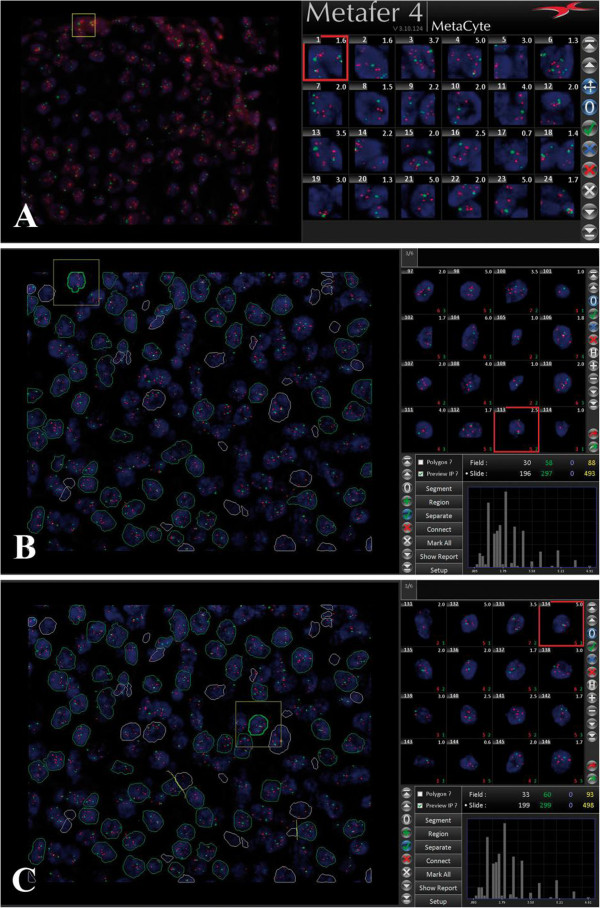
Image analysis of fluorescence signals. A). Automated quantitative image analysis through the tile-sampling classifier. Non-overlapping square tile were placed on DAPI-counterstain image in order to maximize the nuclear material covered. Each tile may contain a single nucleus or portions of one or more nuclei. The software effectuated the spot count in each tile. B). Quantitative image analysis through the automated nuclei-sampling classifier. The classifier automatically recognized individual nuclei in counterstain image (same image as in Figure 1A). Nuclei that were automatically recognized and considered in the analysis showed green outlines, while nuclei that were automatically recognized but not considered in the analysis had a white outline. The software effectuated spot count in each nucleus. C). After completion of the automated image analysis, the user could improve the selection of automatically selected nuclei via interaction with the software. In this particular case, some nuclei that were not yet considered during the automatic segmentation (Figure 1B) were selected by the user, some automatically selected nuclei were deleted and some overlapping nuclei were divided (yellow line between two overlapping nuclei).